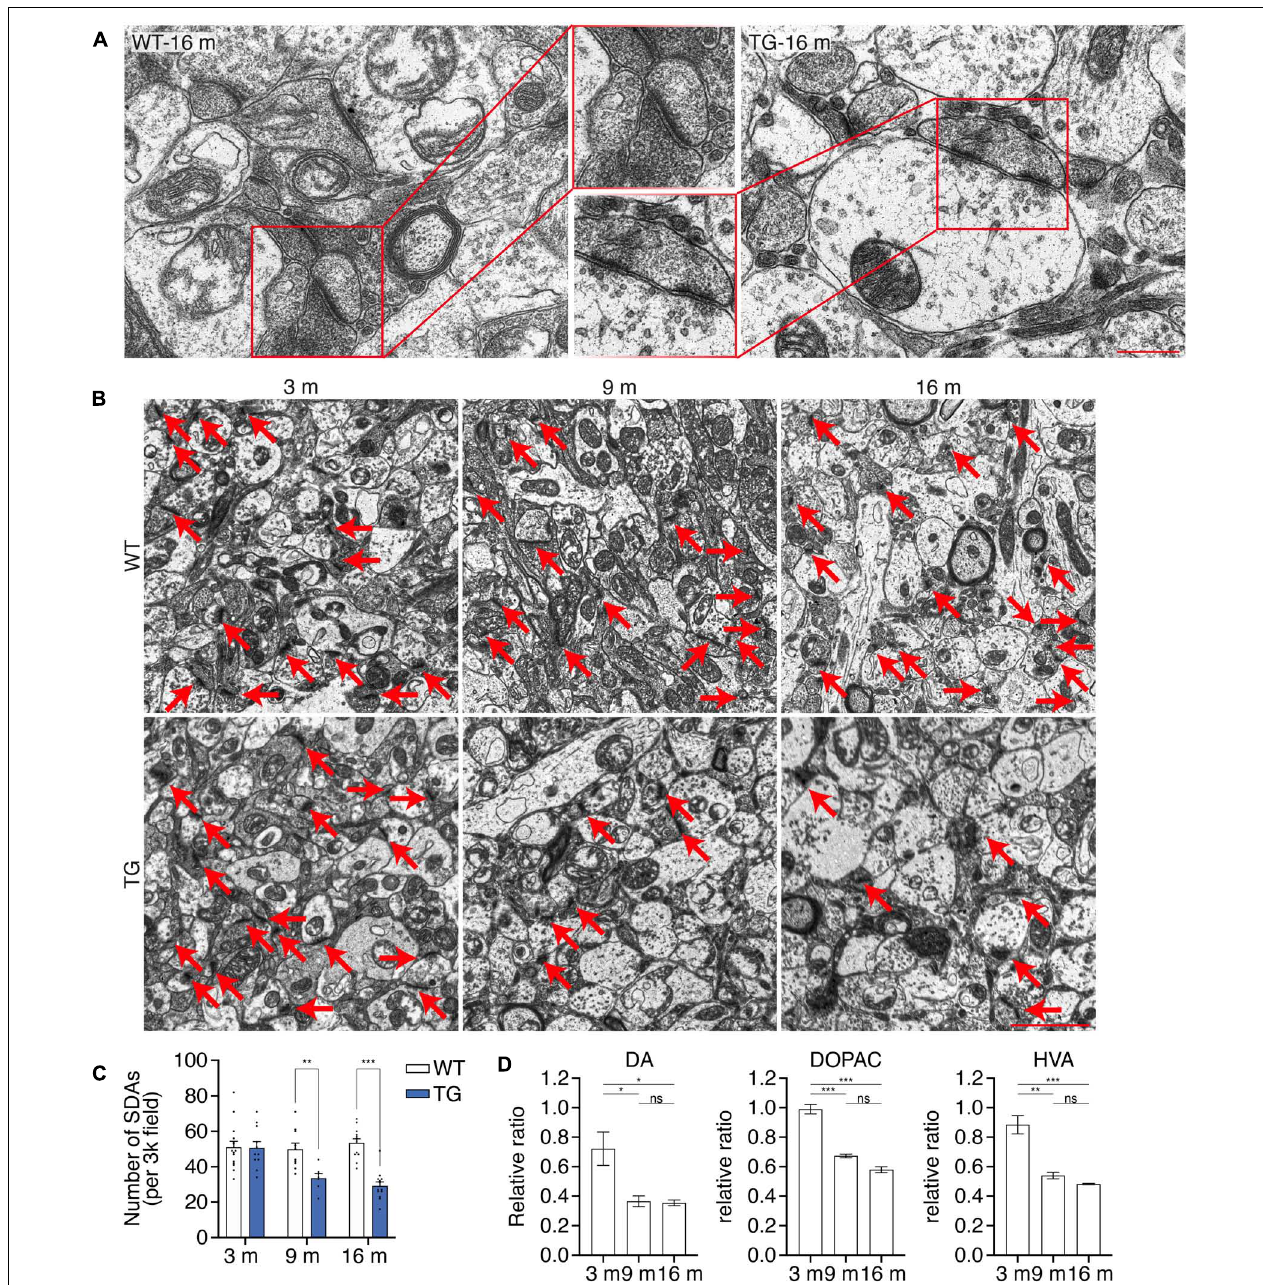
FIGURE 4 | N103 mice demonstrate significant striatal synaptic degeneration. (A) Representative TEM images of the striatal synaptic vesicles in the aged WT control and N103 mice. Scale bar, 0.5 µ m. Regions of interest were zoomed. (B) TEM images of the striatal synapses. Red arrows indicate the synaptic dense areas (SDAs). Scale bar, 2 µ m. (C) Bar graph, quantification of the number of SDAs per 3k field. Data are mean ± s.e.m.; images from n = 3 mice per group; ** P < 0.01 and *** P < 0.001 by two-way ANOVA and Bonferroni’s multiple comparisons. (D) HPLC analysis of the striatal neurotransmitters (DA, DOPAC, and HVA) in N103 mice and WT littermates. Data are mean ± s.e.m.; samples from n = 3 mice per group; * P < 0.05, ** P < 0.01, *** P < 0.001 by Mann–Whitney U